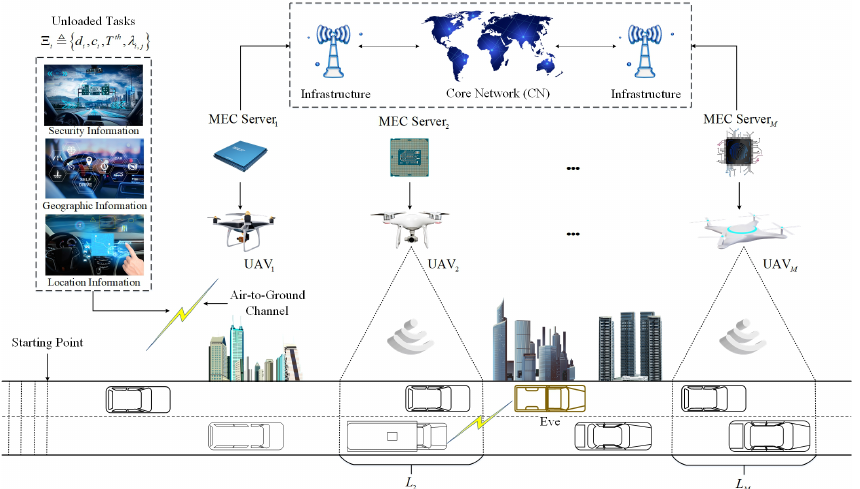
Figure 2. Joint task offloading, resource allocation, and security assurance for MEC-enabled UAV- assisted